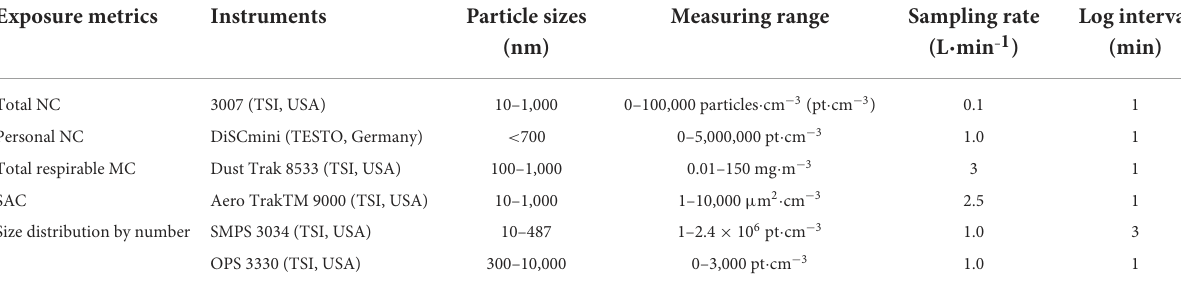
TABLE 1 The main instruments and